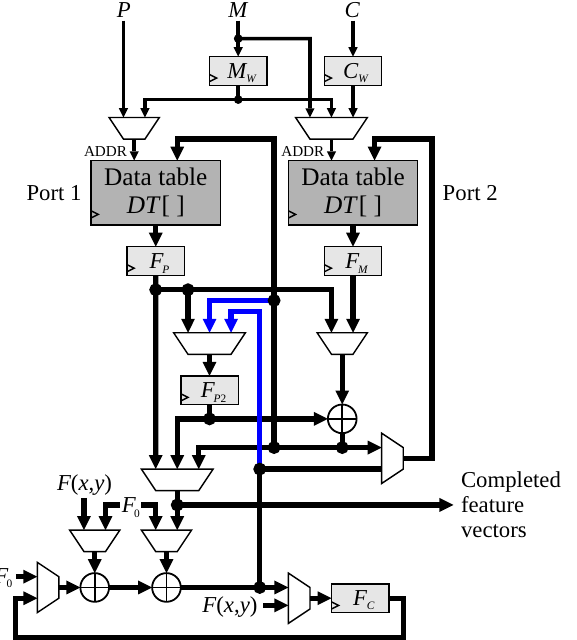
Figure 9. Detailed architecture of the data table processing. Only the data path is shown. The thicker lines represent the feature data. Data forwarding connections are shown in blue. F 0 represents the null feature vector (containing empty